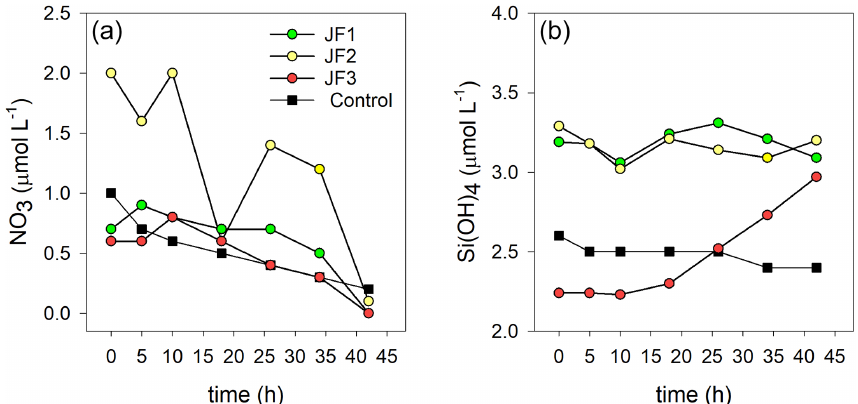
Figure A1. Changes in the concentrations (µmolL − 1 ) of (a) NO 3 and (b) Si(OH) 4 in the experimental cylinders enriched with carcasses of the jellyfish R. nomadica (JF1–JF3) and in the controls ( N = 3).